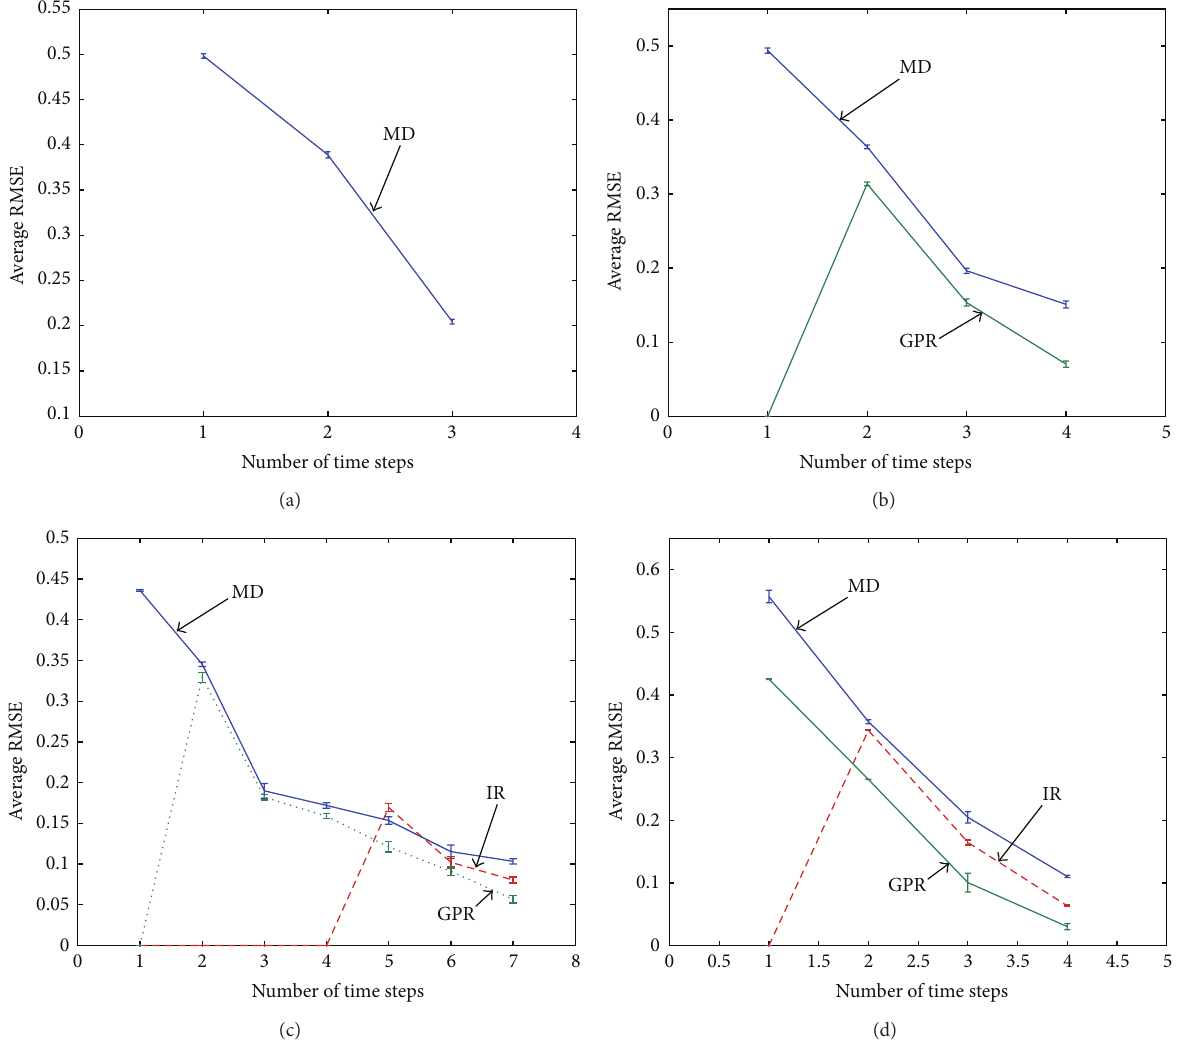
Figure 13: Average RMSE in the environment with 5 MD sensors (a), 5 MD and 1GPR sensor (b), 5 MD, 1IR, and 1GPR sensors (c), and 2 MD, 2 IR, and 2 GPR sensors